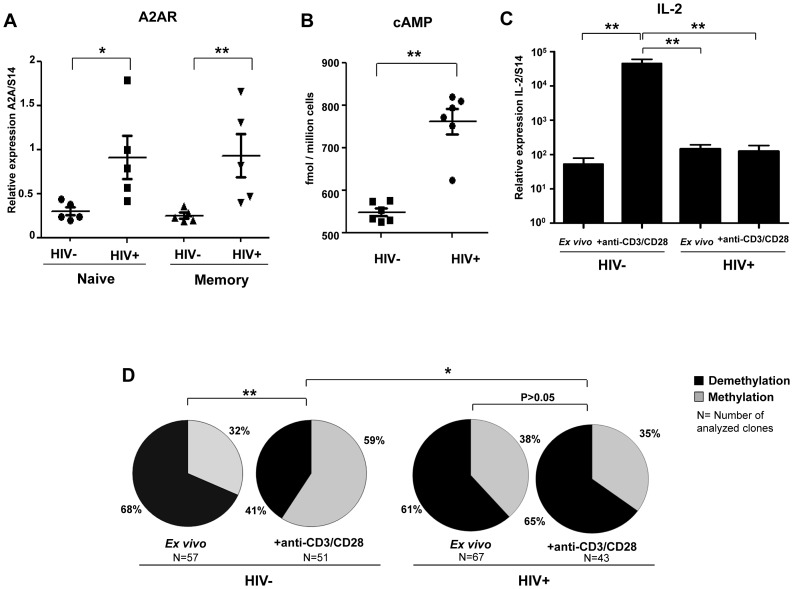
High levels of A2AR and endogenous cAMP in CD4+ T cells from HIV infected patients and lack of IL-2 production. (A) CD45RA+ and CD45RA− CD4+ T cells were purified from the blood of ART-naive HIV-infected patients (n = 5) and healthy controls (n = 5). A2AR mRNA expression was assessed using qPCR. Horizontal lines correspond to the mean for each data set. (B) CD4+ T cells were purified from the blood of ART-naive HIV-infected patients (n = 6) and healthy controls (n = 8). Intra-cellular cAMP is measured using the cAMP direct enzyme immunoassay from GE healthcare Biosciences. (C) Purified naive CD4+ T cells form HIV+ART- patients and healthy controls were stimulated with high doses of anti-CD3/CD28 mAbs (5 µg/ml) during 6H and IL-2 mRNA levels were quantified by RT-PCR. (D) The epigenetic changes on methylation of the unique essential CpG site of il-2 gene promoter in naïve CD4+ T cells from HIV+ART- patients vs. healthy controls following anti-CD3/CD28 mAbs activation. To reach the technical limitation due to the low frequency of naïve CD4+ T cells in HIV+ART- patients, the Clonal analysis was performed on a pool of the extracted DNA from naïve CD4 T cells of HIV+ patients and healthy controls before and after CD3/CD28 mAbs activation. *P<0.05, **P<0.01.